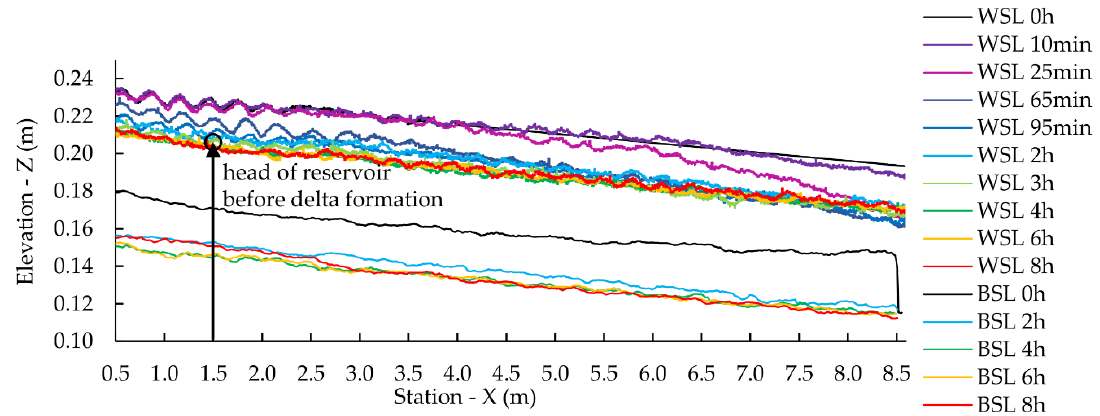
Figure 7. Bed and water surface profiles for test run E2 at the head of the reservoir at a flow rate of 0.7 × HQ 1 during flushing. WSL = water surface levels, BSL = bed surface levels. 0.7 × HQ 1 during flushing. WSL = water surface levels, BSL = bed surface